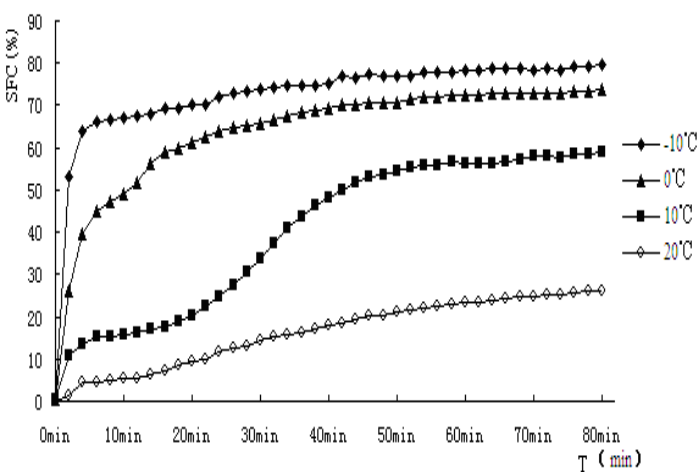
Figure 6. Solid fat content vs. time of crystallization for